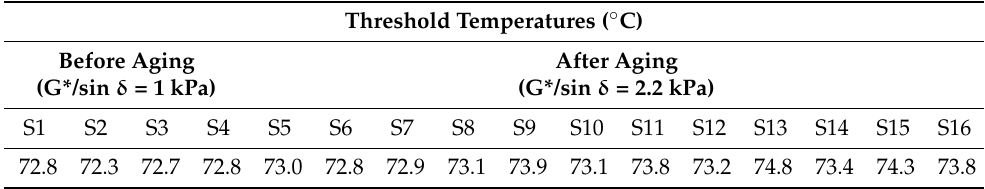
Table 4. Bitumen threshold temperatures under different concentrations of fumed silica NPs before and after